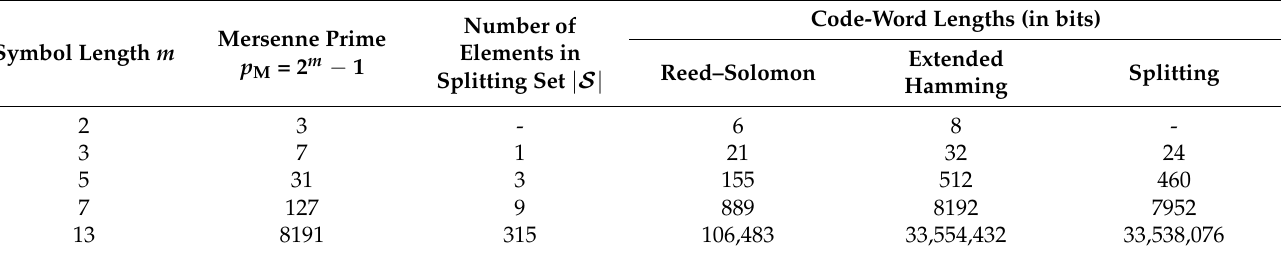
Table 1. Mersenne primes and code-word lengths for RS, extended Hamming and splitting code. Mersenne Symbol Length m